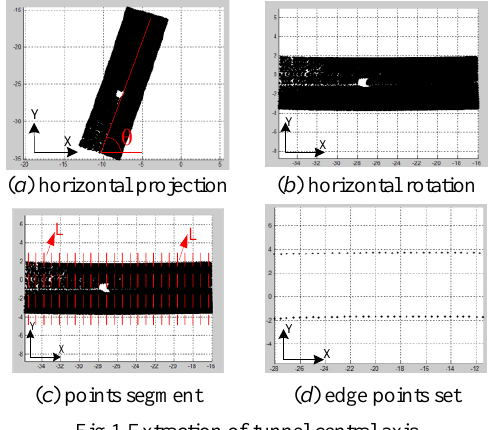
Fig.1 Extraction of tunnel central axis